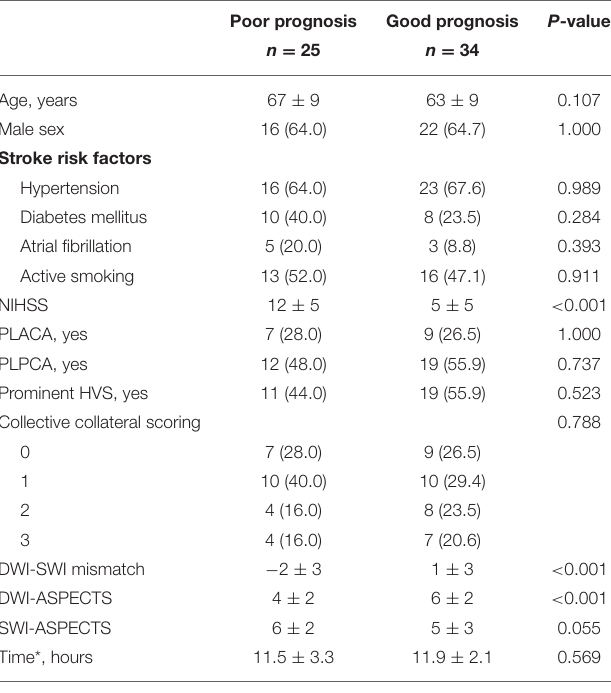
TABLE 1 | Baseline clinical and imaging data of patients with MCA M1-segment occlusion, shown by prognostic status. Poor prognosis Good prognosis